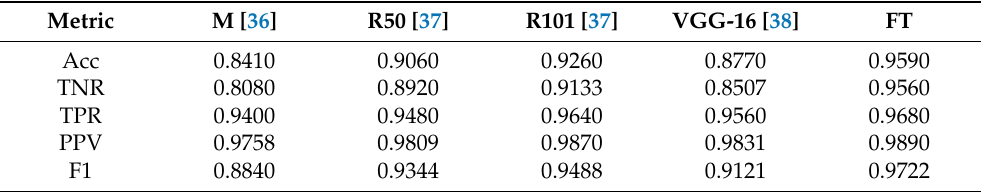
Table 9. Performance comparison on the Zhang OCT dataset. The proposed framework with ResNet101 [37] achieved comparable performance to the fine-tuned